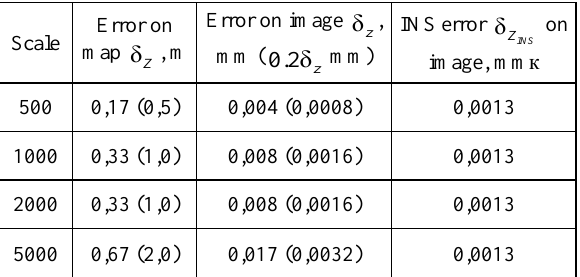
Table 4. Comparative analysis of calculated and acceptable INS errors (axis